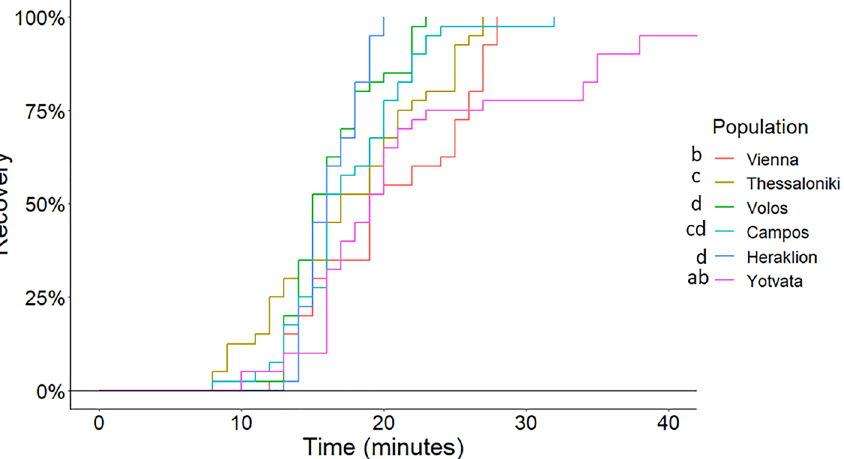
Figure 6. Kaplan–Meier recovery curves of adults from six Ceratitis capitata populations. Adults were exposed at 0 °C for 4 h and transferred for recovery at 25 °C. Populations labeled with the same lower case letter are not significantly different from each other (log rank test: p > 0.05). N = 40 adults per